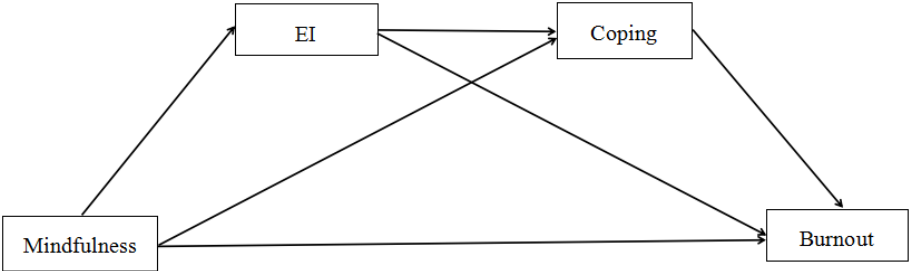
Figure 1. The proposed chain mediating model. EI = emotional intelligence.